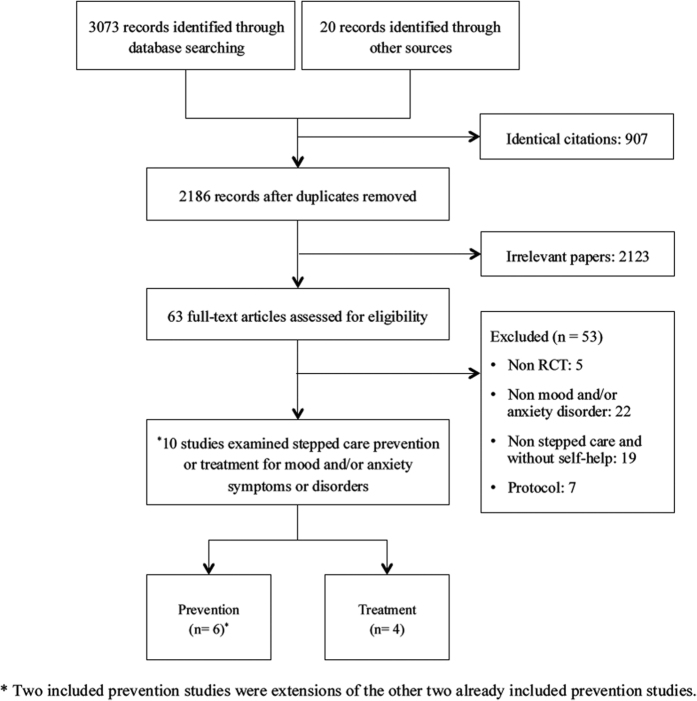
Selection Flow of Trials for Inclusion in the Review.